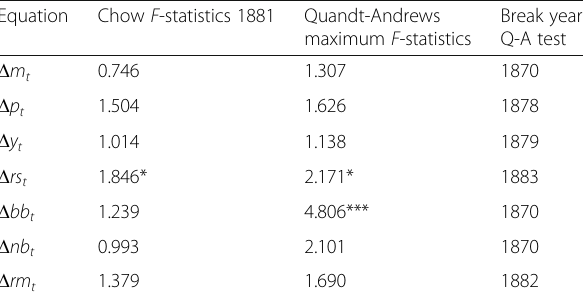
Table 4 Stability tests for the single EC equations 1851 – 1906